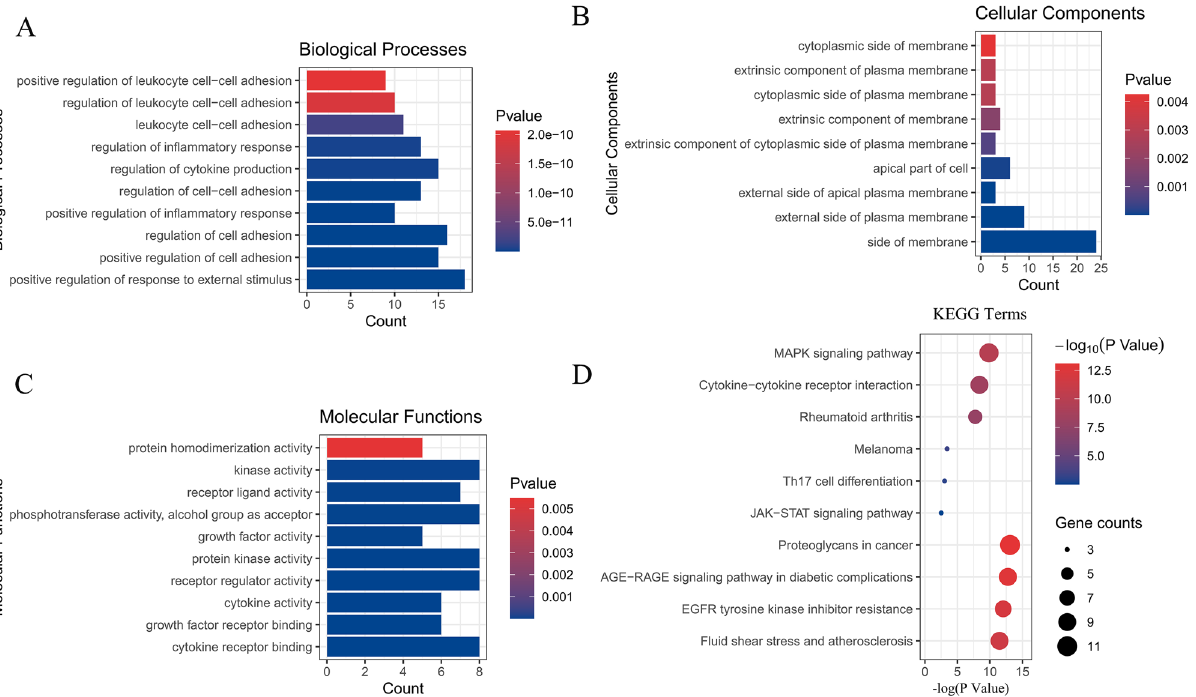
Figure 6. GO and KEGG enrichment analysis of 48 common targets. ( A – C ) are biological processes, cellular components, and molecular functions in GO analysis. D is the KEGG enrichment analysis item. All show the top 10.